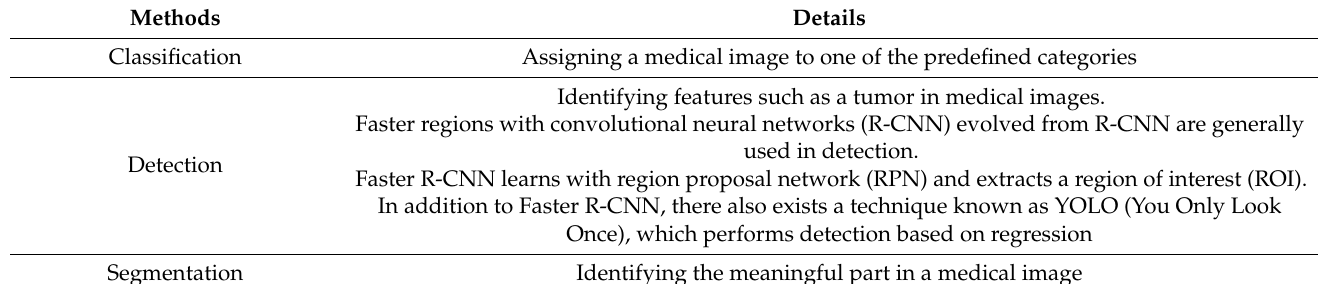
Table 4. AIMD analysis